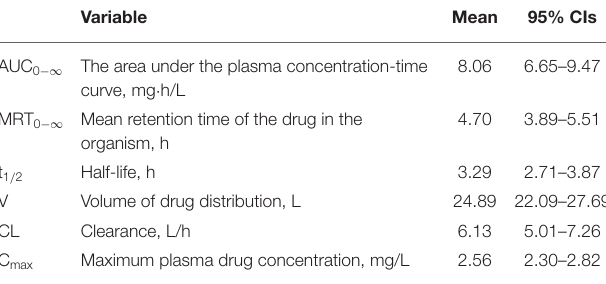
TABLE 2 | The pharmacokinetic parameters of